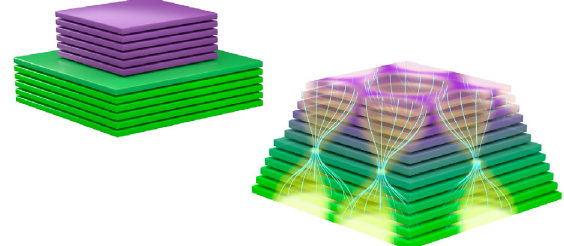
FIG. 1. Two-dimensional heterostructure composed of two mismatched (green and purple) materials. Left panel: Lego- bricklike illustration in which no atomic relaxation occurs [56]. The two materials have different lattice constants visualized by the width of the stacks. Right panel: illustration including the main finding of this work — layers relax continuously away from the interface. The extent of relaxation is qualitatively encoded in the yellow color. The emergent moir´e pattern slowly decays toward the outer layers of the stack. interplay of mechanical relaxation between different layers. We contrast the two paradigms in Fig. 1, where the left panel illustrates how to understand a stack of two multi- layered, mismatched materials in the picture disregarding relaxation. As no relaxation occurs, there is a sharp transition from the bottom stack (green) to the top stack (purple) visualized by the difference in width. In contrast,